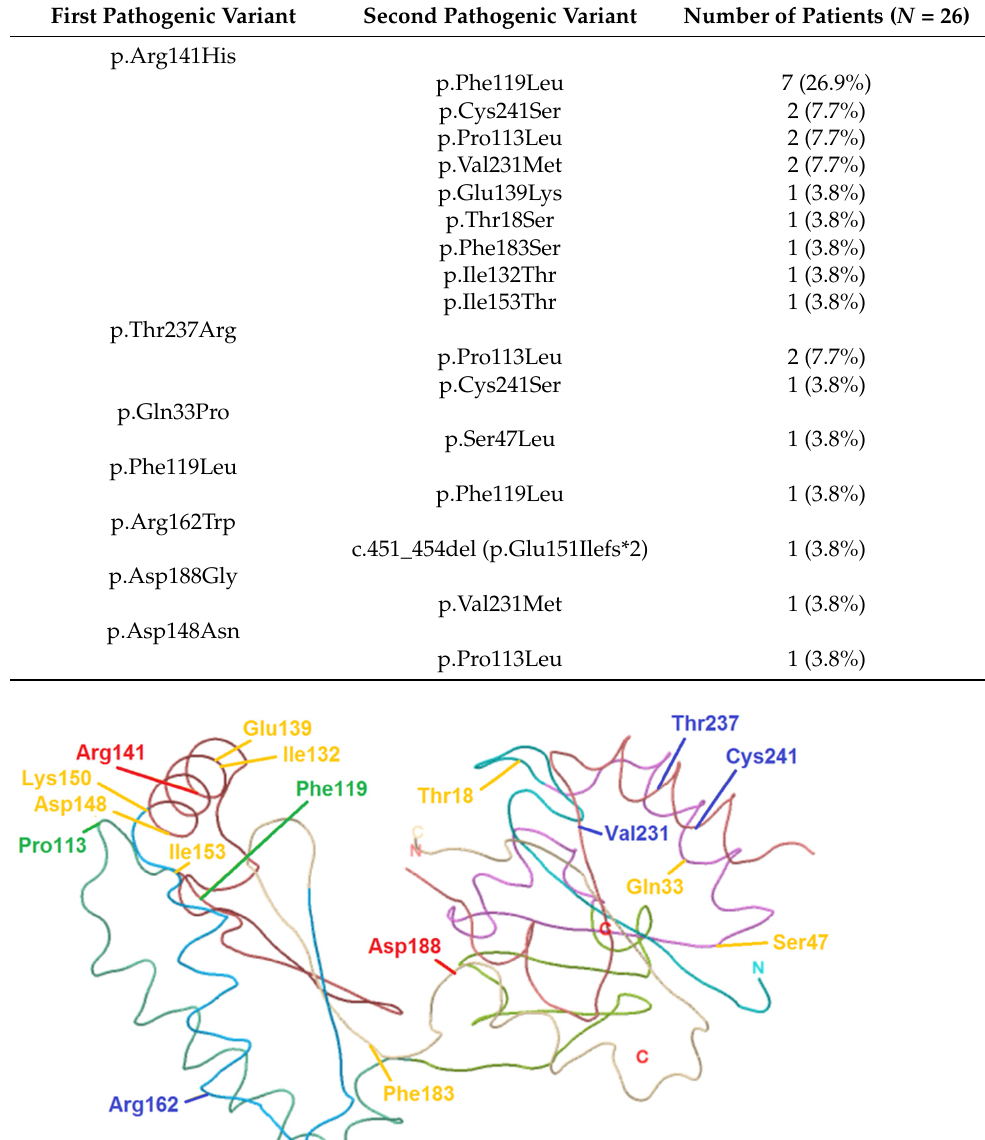
Table 1. Distribution of the different pathogenic variants found in all 26 patients and their perspective percentages in parentheses.